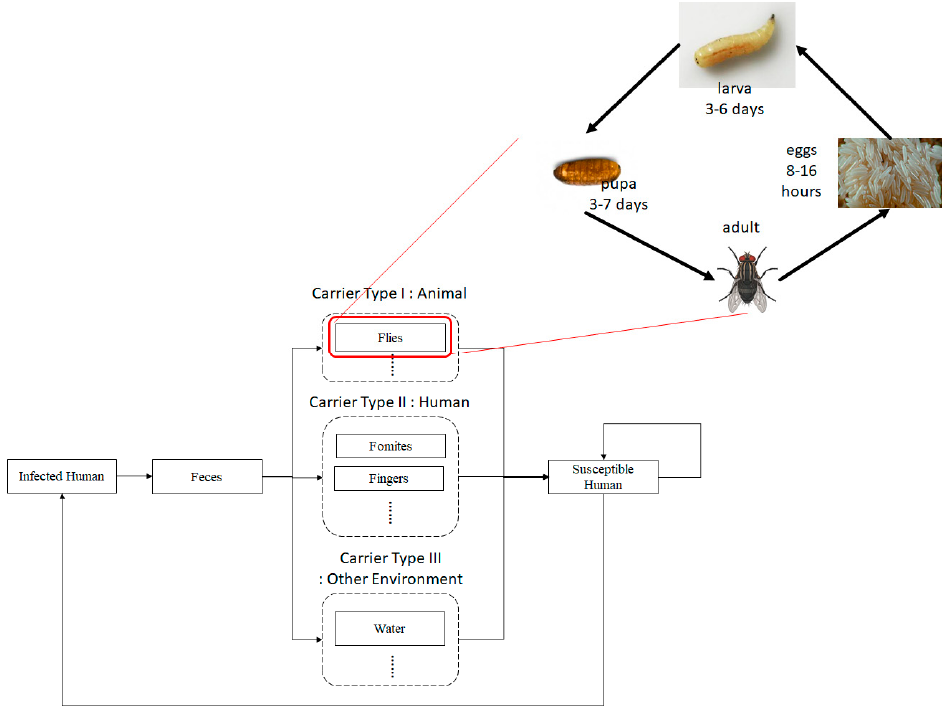
Figure 1. Flow diagram of disease transmission through multiple carriers and a life cycle of a fly as a principal disease carrier.